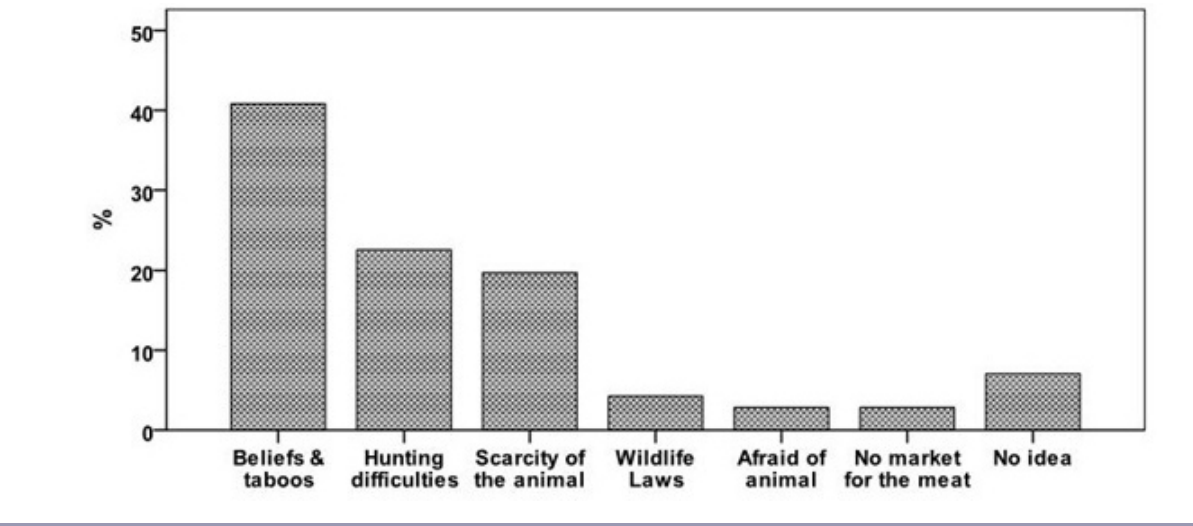
Fig. 2. Reasons for not hunting gorillas as reported by hunters in five villages in Lebialem Division, July 2007 (percentage of respondents who reported themselves as hunters, n =